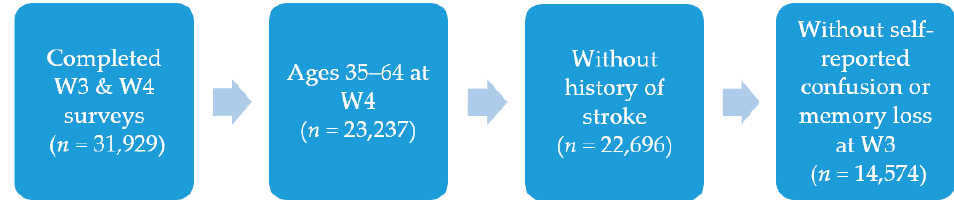
Figure 1. Study sample inclusion criteria.